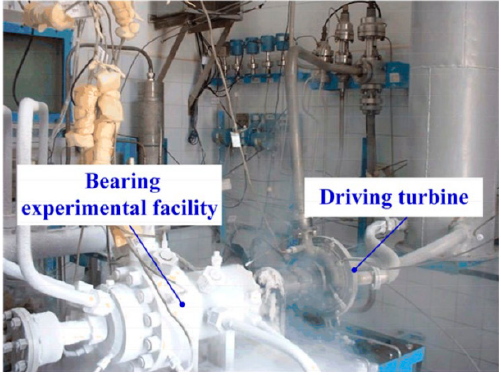
Figure 21. Ultra-low temperature ball bearing testing machine.